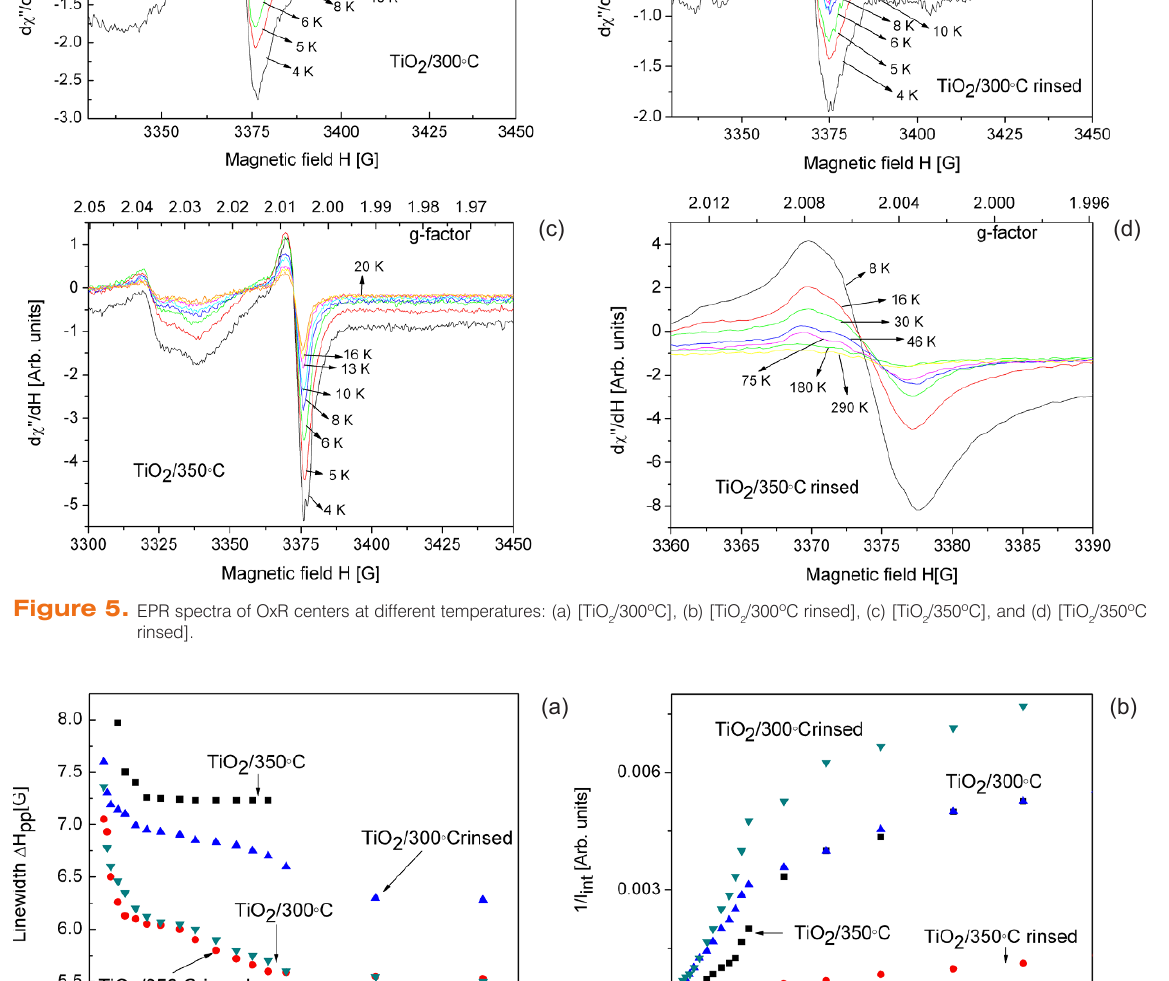
Figure 6. Temperature dependence of the linewidths (a) and the reciprocal of integrated intensities (b) of OxR centers in four investigated